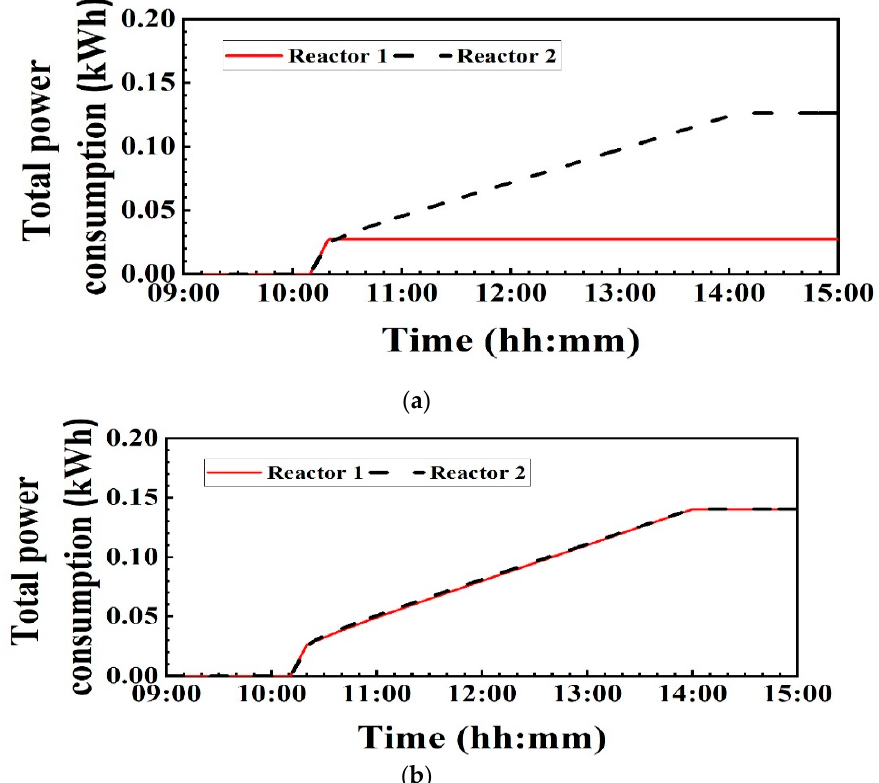
Figure 6. Total power consumption of the reactors under ( a ) a sunny conditions (15th November 2019) and ( b ) overcast conditions (6th December 2019).